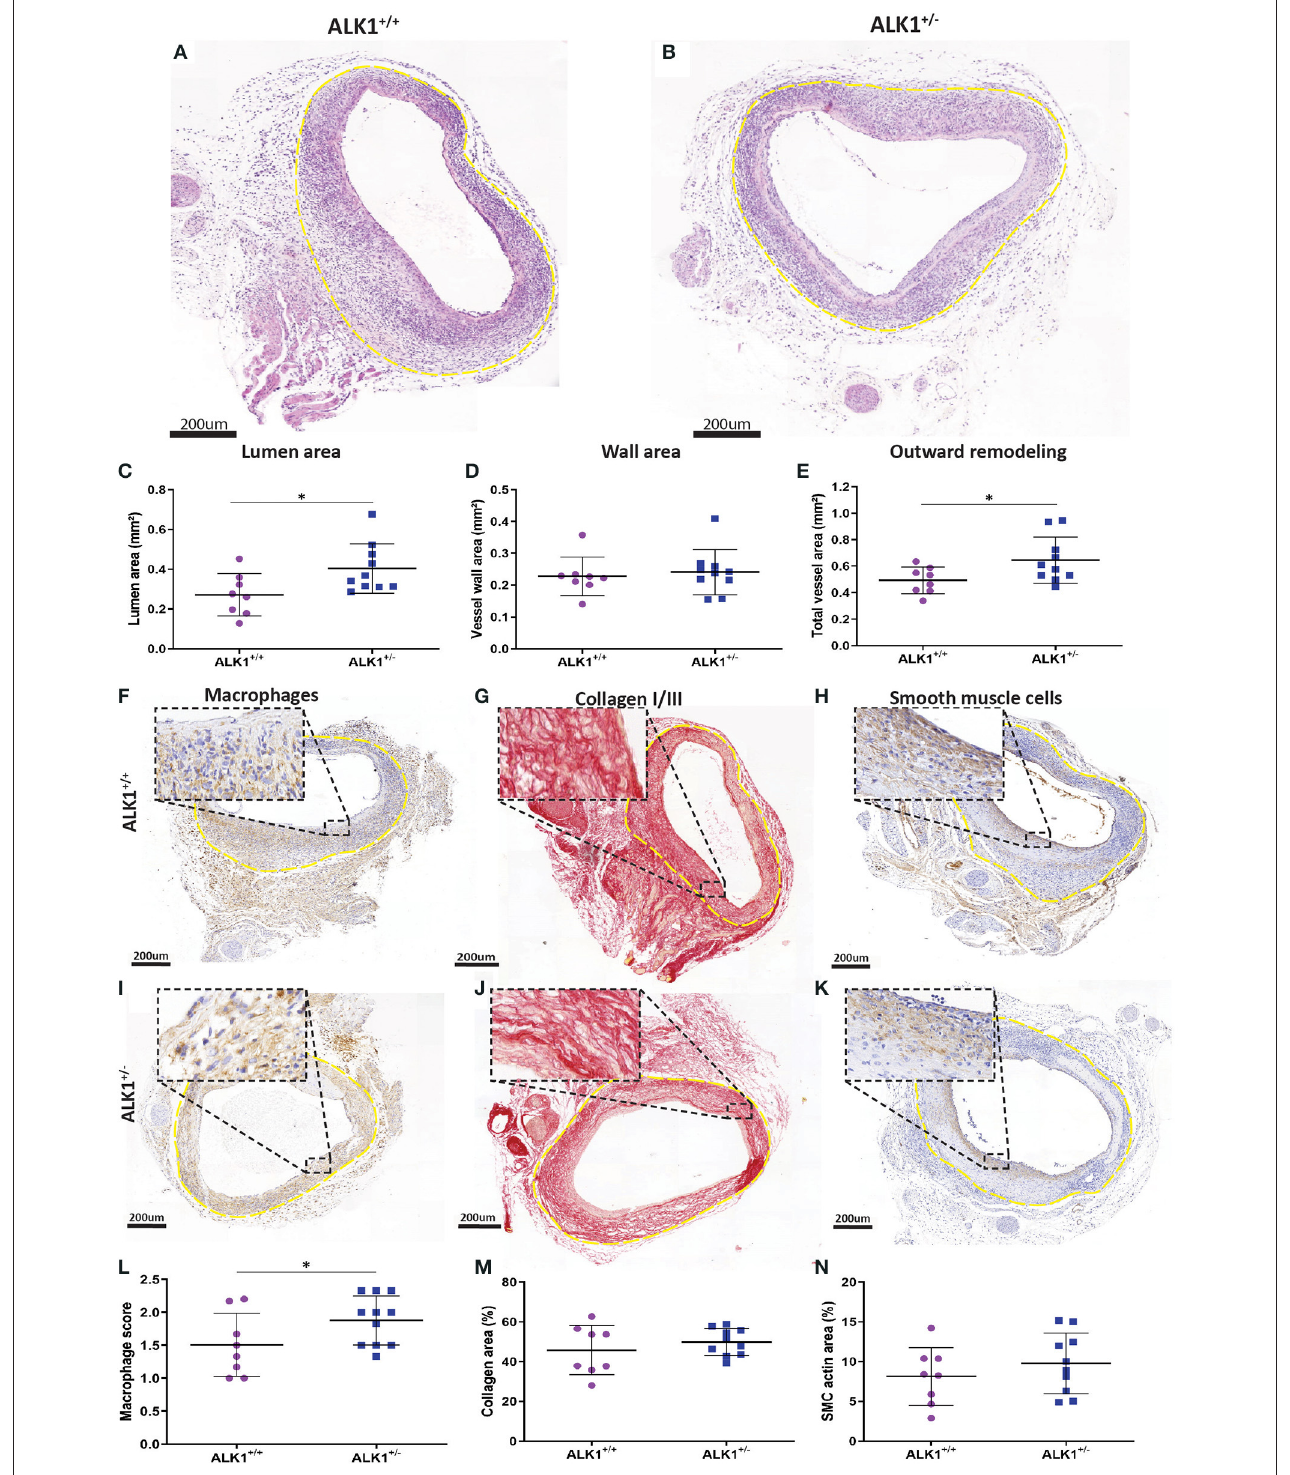
FIGURE 1 | Morphometric and compositional analysis of ALK1 + / − and ALK1 + / + vein grafts. Vein grafts from ALK1 heterozygous mice (ALK1 + / − , n = 7) were compared to vein grafts from ALK1 + / + ( n = 10) mice. Typical examples of a vein graft from an ALK1 + / + mouse (A) and a vein graft from an ALK1 + / − mouse (B) . The outer adventitial layer is highlighted by the dotted yellow line. The morphometric parameters in mm 2 represent the vein graft lumen area (C) , the vein graft wall area (D) , and the total vein graft area (E) . The composition of the vein grafts was evaluated by visualizing the macrophages (F,I) collagen (G,J) and the vascular smooth muscle cells (H,K) in vein grafts from ALK1 + / + and ALK1 + / − mice. Quantification of the macrophage score (L) , collagen area (M) , and smooth muscle cell positive area (N) . Statistical evaluation was performed with the unpaired parametric T -test, * p < 0.05.